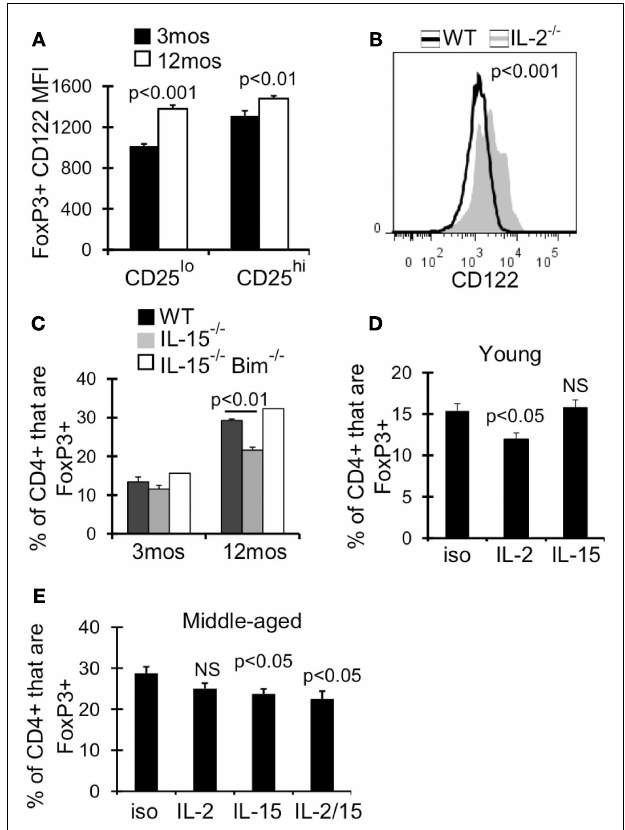
FIGURE 6 | IL-15 antagonizes Bim to promoteT reg homeostasis in middle-aged mice . Splenocytes from 3month ( n = 4) and 12-month-old ( n = 4) mice (A) or 5-week-oldWT ( n = 4) and IL-2 − / − ( n = 3) mice (B) were stained for CD4, FoxP3, and CD122, and analyzed by flow. (A) Results show the MFI of CD122 on CD4 + FoxP3 + cells ( ± SE). (B) Histograms show CD122 expression on CD4 + FoxP3 + cells.The p value represents the difference between the average CD122 MFI fromWT and IL-2 − / − mice (Student’s t test). (C) Splenocytes fromWT ( n = 3–4/group), IL-15 − / − ( n = 3/group), and IL-15 − / − Bim − / − ( n = 2/group) were stained for CD4 and FoxP3 and analyzed by flow. Results show the frequency of CD4 + cells that are FoxP3 + ( ± SE) and are representative of two independent experiments. Young (3months; n = 4/group) (D) and middle-aged (12months; n = 5/group) (E) mice were injected with IL-2 and/or IL-15 neutralizing antibody or with IgG isotype control. Spleens were harvested at day 7 and stained for CD4, FoxP3, CD25, and Bim. (D,E) Results show the frequency of CD4 + cells that are FoxP3 + ( ± SE).The p values represent the difference between antibody treated and isotype control (Student’s t test).